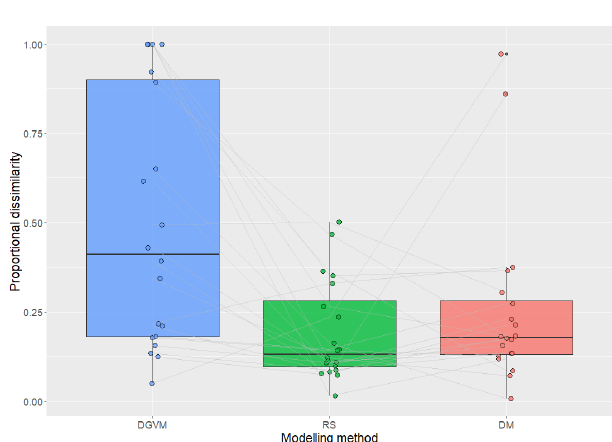
Figure 2. Proportional-dissimilarity values between PFT profiles for each combination of 20 plots and each of the three methods compared in this study and the corresponding plot in the AR ref- erence dataset. The thick horizontal line, the box and the whiskers represent the median, the interquartile difference and the range of values for each